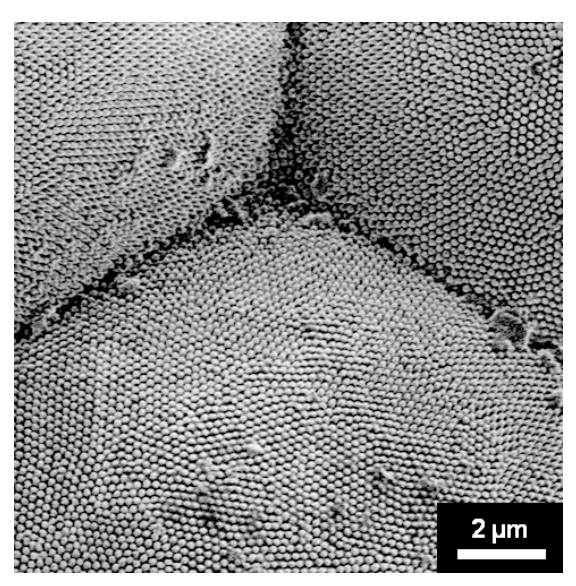
Figure 3: Topological disorder in the hexagonal nipple structure showing two pairs of 5–7 (“ • ”–“ X ”) coordination defects (magnification: